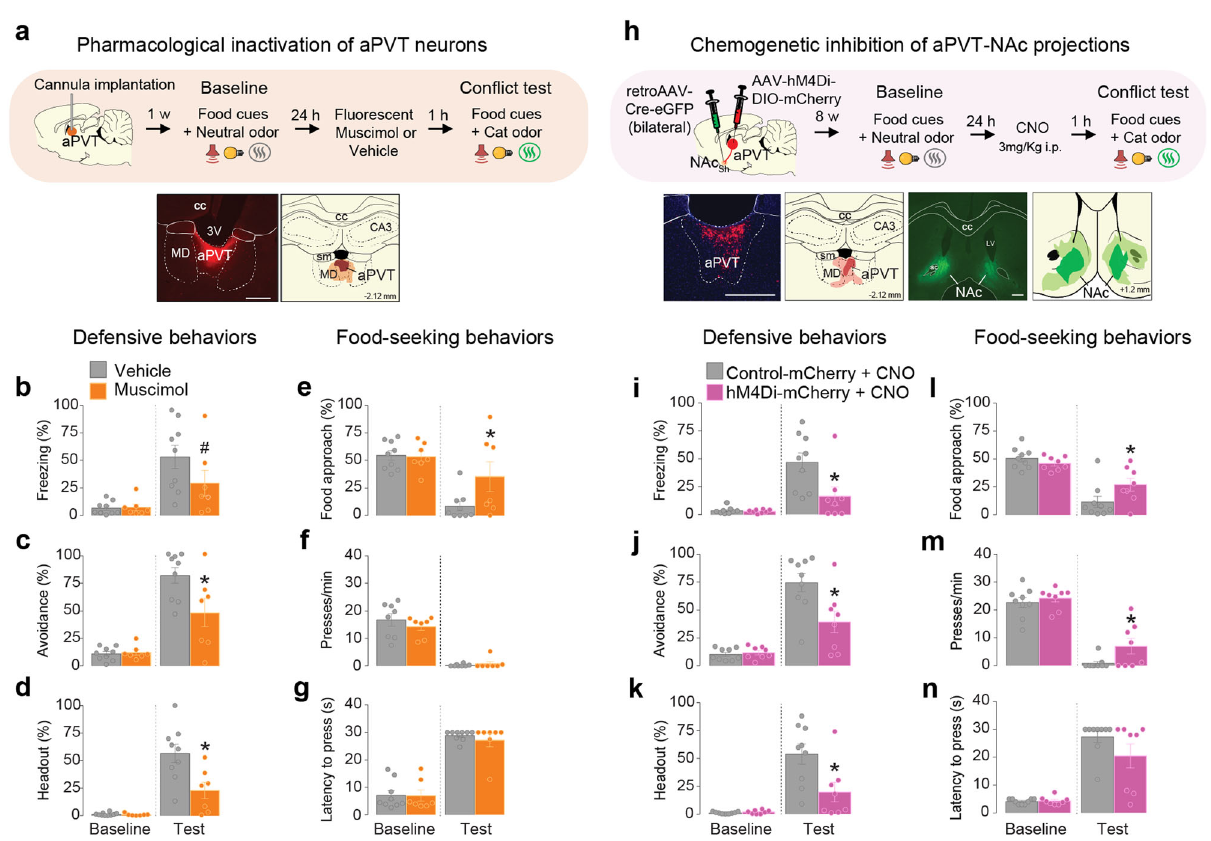
Fig. 3 Pharmacological inactivation of aPVT neurons or chemogenetic inhibition of aPVT-NAc neurons biases behavior towards food seeking. a (Top) Timeline of the approach-avoidance con fl ict test during pharmacological inactivation of aPVT neurons. (Bottom left) Representative micrograph showing the site of fl uorescent muscimol microinjection into aPVT. (Bottom right) Orange areas represent the minimum (dark) and the maximum (light) spread of muscimol. b – g Muscimol inactivation of aPVT neurons (orange bars, n = 7) during the con fl ict test reduced the percentage of time rats spent exhibiting c avoidance ( F (1, 14) = 5.59, P = 0.033) and d head-out responses ( F (1, 14) = 8.58, P = 0.011), and increased e food-approach time ( F (1, 14) = 3.588, P = 0.079, with a Bonferroni planned comparison P = 0.026). Animals also exhibited a trend to reduce b freezing ( F (1, 14) = 2.25, P = 0.155, Bonferroni planned comparison P = 0.092). No changes were observed in f lever presses ( F (1, 14) = 1.207, P = 0.29) and g latency to press ( F (1, 14) = 0.28, P = 0.60), when compared to vehicle controls (gray bars, n = 9). h (Top) Timeline of the approach-avoidance con fl ict test during chemogenetic inhibition of aPVT-NAc neurons. (Bottom left) Representative micrograph showing the expression of hM4Di into the aPVT. Red areas represent the minimum (dark) and the maximum (light) viral expression into the aPVT. (Bottom right) Representative micrograph showing the site of microinjection of retrograde AAV-Cre-GFP into the NAc. Green areas represent the minimum (dark) and the maximum (light) viral expression into the NAc. i – n Chemogenetic inhibition of aPVT-NAc neurons (pink bars, n = 8) reduced the percentage of time rats spent exhibiting i freezing ( F (1, 15) = 6.22, P = 0.024), j avoidance ( F (1, 15) = 10.58, P = 0.005), and k head-out ( F (1, 15) = 8.07, P = 0.012) responses, and increased l food-approach time ( F (1, 15) = 7.48, P = 0.015) and m lever presses ( F (1, 15) =